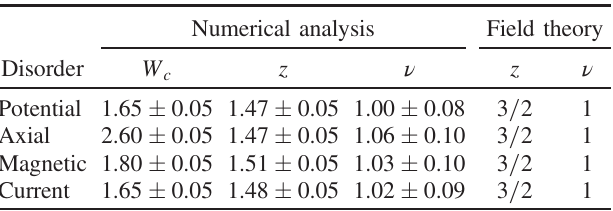
TABLE II. Numerically extracted critical strength of disorder TABLE I. Comparison of numerically extracted values of ), dynamic scaling exponent ( z ), and for WSM-metal QPT ( W dynamic scaling exponent ( z ) and correlation length exponent c correlation length exponent ( ν ) in the presence of four individual ( ν ) across the WSM-metal QPT (takes place at W ¼ W ), with the c disorder potentials that mix two Weyl nodes (nonchiral disorder), ones obtained from the leading-order ϵ expansions using field- obtained from the scaling of average DOS. The fact that z ≈ 1 . 5 for theoretic techniques. All four disorders preserve continuous global all types of disorder reflects through almost linear scaling of DOS chiral symmetry of a WSM. This comparison strongly suggests around the WSM-metal QPT; see Fig. 3 (lower panel). For field- that a WSM-metal transition driven by a CSP disorder is theoretic analysis of internode scatterers or nonchiral disorder, see insensitive to the nature of elastic scatterers, thus motivating an Sec. VII. Here, error bars in z and ν are fitting error bars (see emergentchiralsuperuniversalityclass ofthe QPTs, cf.Sec.V.The Fig. 14). For detailed discussion, see Appendix E and Table IV. fact that z ≈ 1 . 5 for all types of disorder reflects through almost linear scaling of DOS around the WSM-metal QPT; see Fig. 3 (top panel). Here, error bars in z and ν are “ fitting error bars ” (see Fig. 13). For detailed discussion, see Appendix E and Table